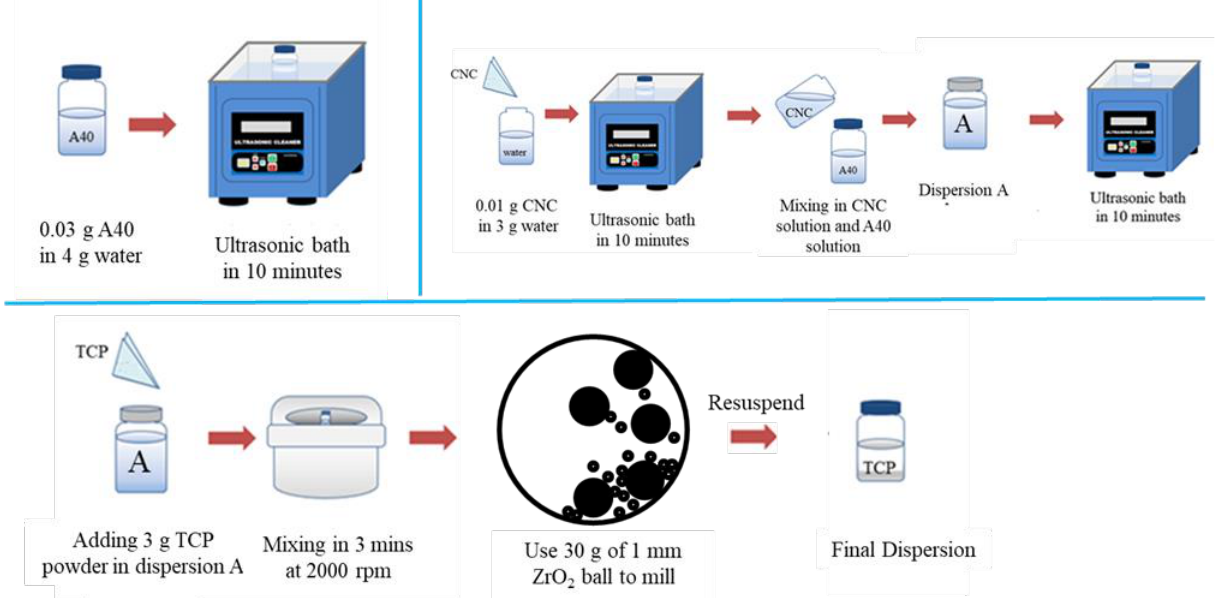
Figure 1. Schematic illustration of the formulation of dispersion.